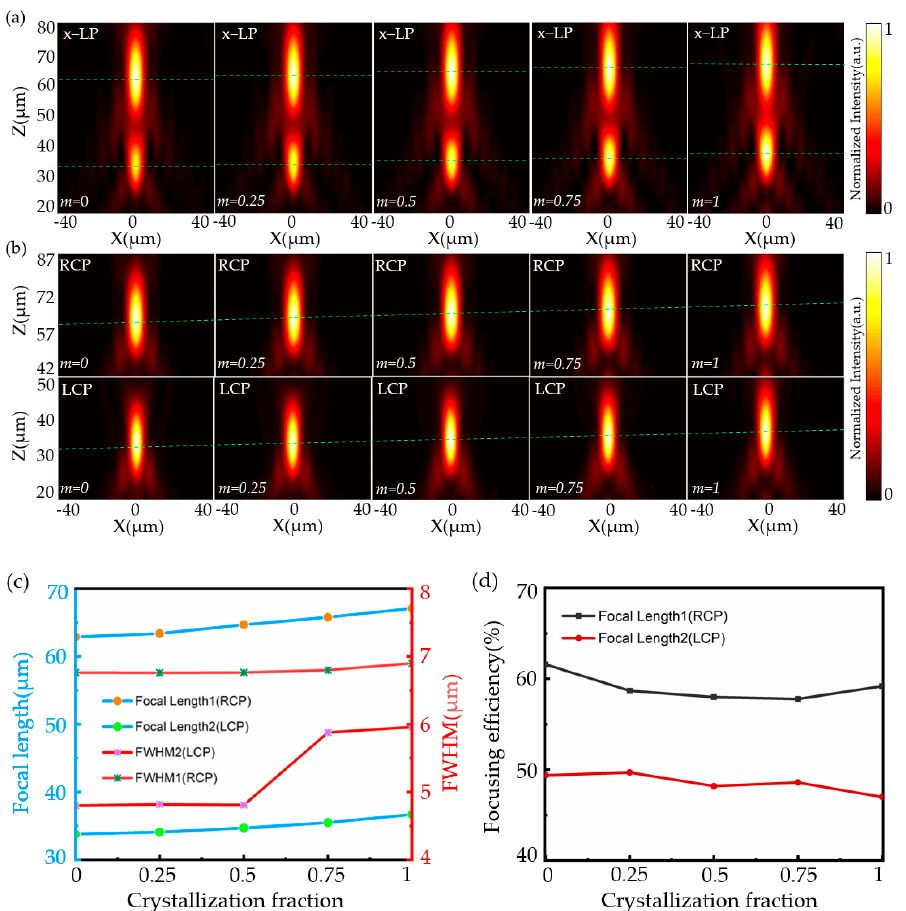
Figure 5. Demonstration of electric field strength in the x − z plane under x-polarized light ( a ), right − handed circular and left − handed circular light incident ( b ) when the crystalline fraction m of GSSe varies from 0 to 1. ( c ) The focal length and FWHM of the metalens correspond to different m under the excitation of RCP and LCP. ( d ) The corresponding focusing efficiencies of the foci in ( c ).